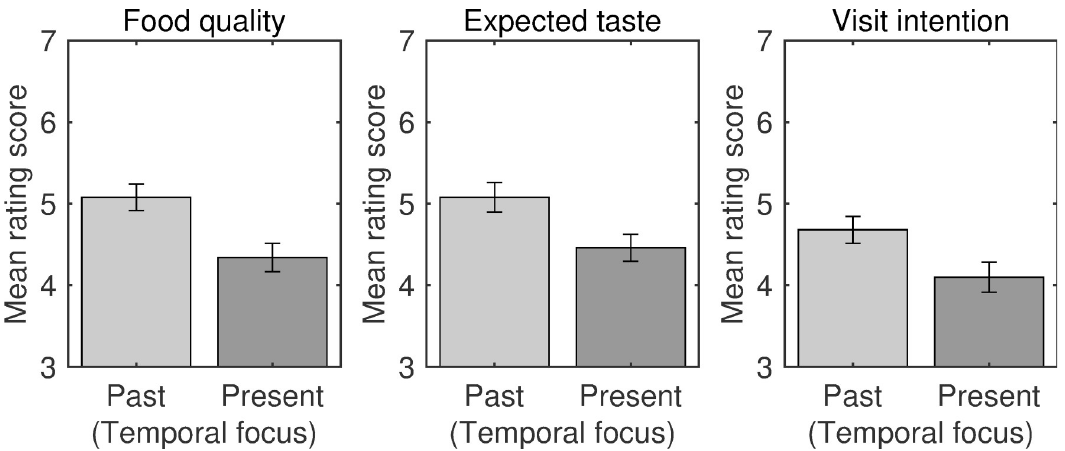
Fig 5. Evaluations of restaurants in Experiment 2. Bar plots for visit intention, expected taste, and food quality ratings are shown separately for the past-focused and present-focused label conditions. Error bars indicate standard error.